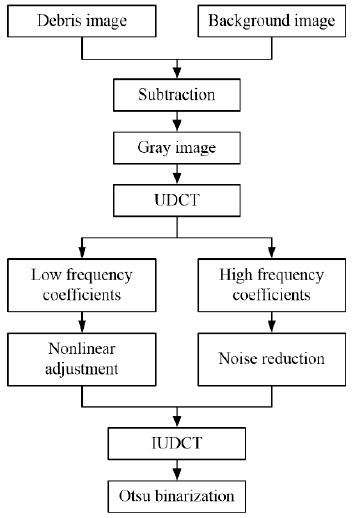
Figure 7. Spectral binarization based on uniform discrete curvelet transform.